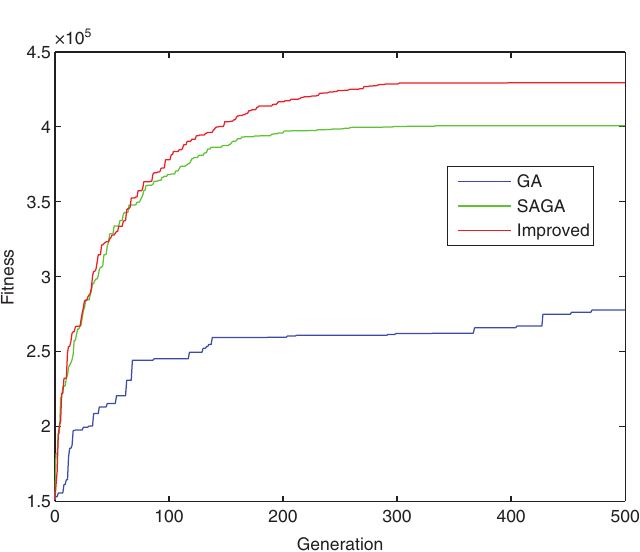
Figure 6. Data Sample